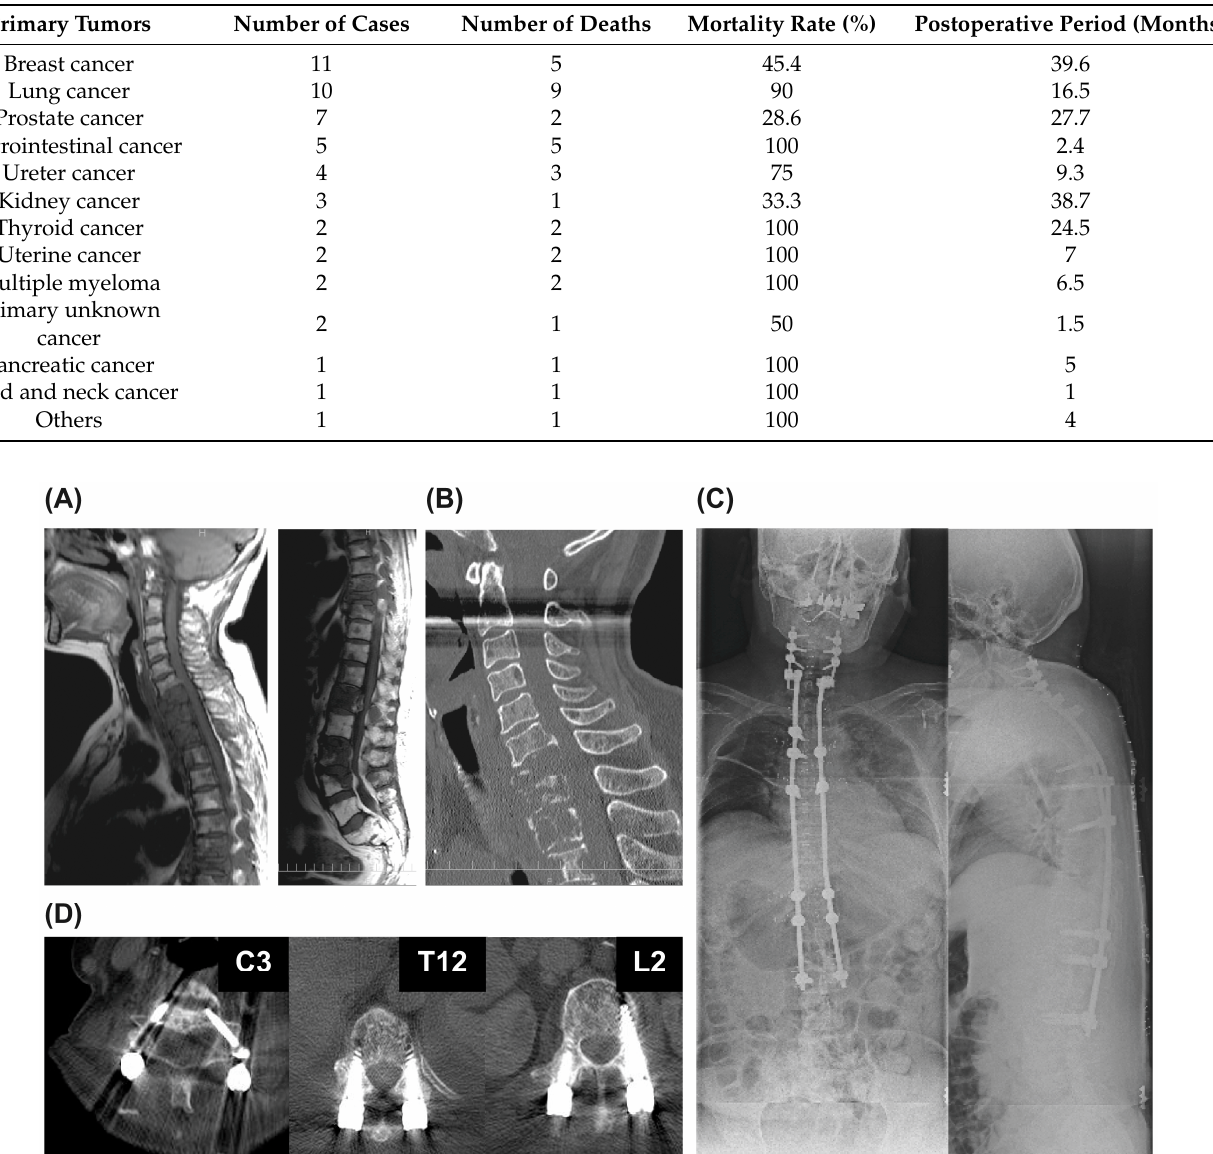
Table 6. Mortality by cancer type.